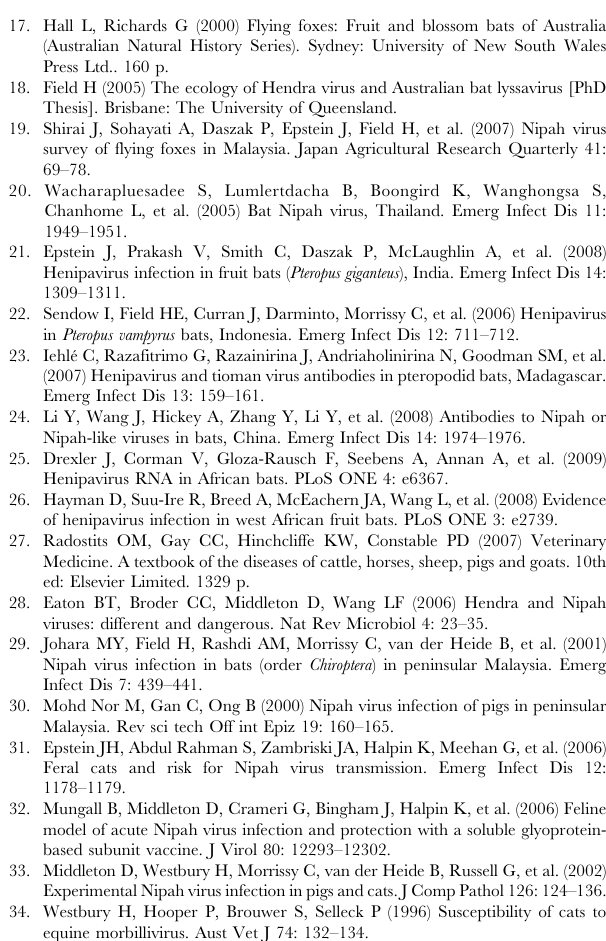
Table S1 Summary of import/movement data and results of the qualitative risk